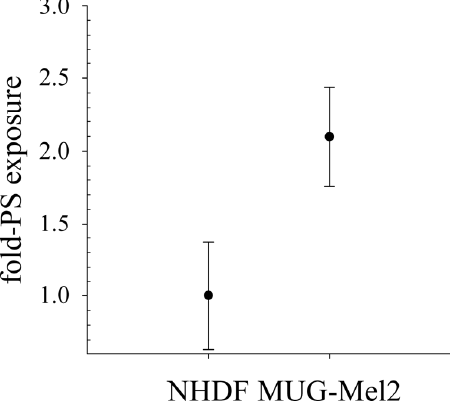
Figure 1. Comparison of PS exposure of normal human dermal fibroblasts (NHDF) with melanoma cell line MUG ‐ Mel2 by measurement of fluorescence of bound Annexin V ‐ Alexa 488. MUG ‐ Mel2 shows significant increase in PS ‐ levels exposed. PI uptake was measured as control to exclude binding of Annexin V to the inner leaflet of plasma membranes due to necrosis. Mean values (black dots) with standard deviations of 4–10 independent experimental data are shown. Respective PS ‐ levels exposed differ significantly (student’s t ‐ test, p < 0.001).